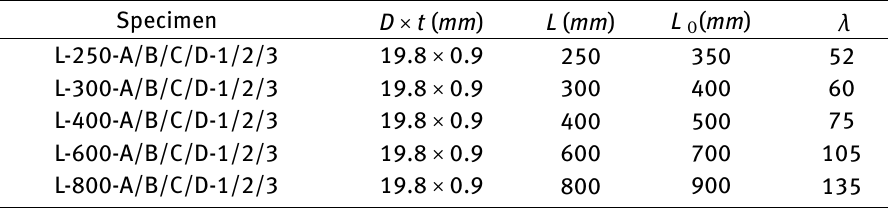
Table 2: Dimensions of the specimens